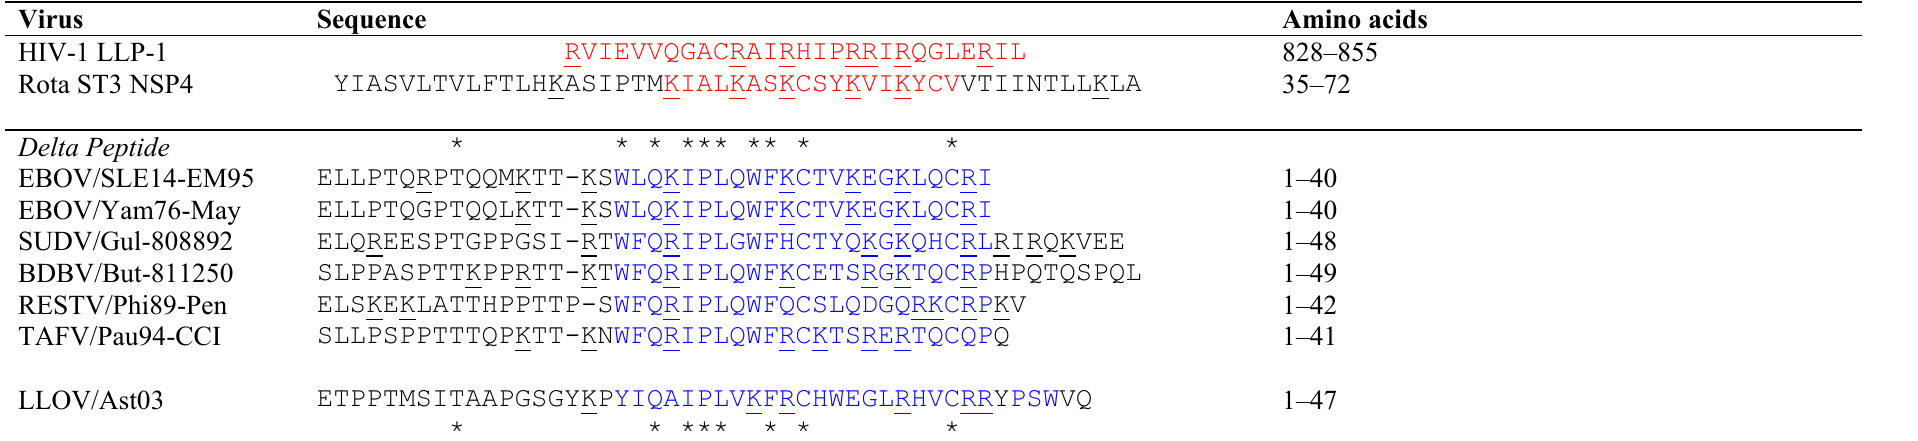
Table 2. Alignment of Membrane Interfacing or Membrane-Spanning Viral Peptide Sequences